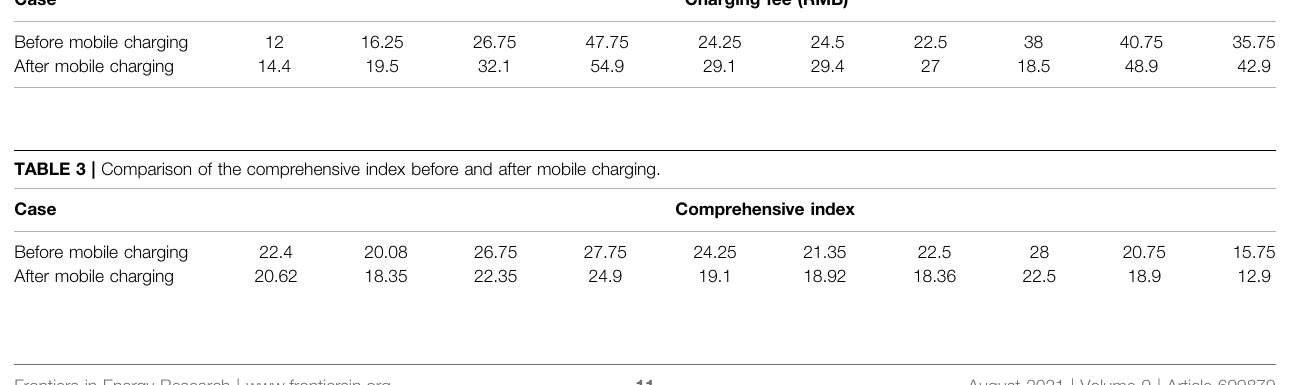
TABLE 2 | Comparison of the charging fee before and after mobile charging. Case